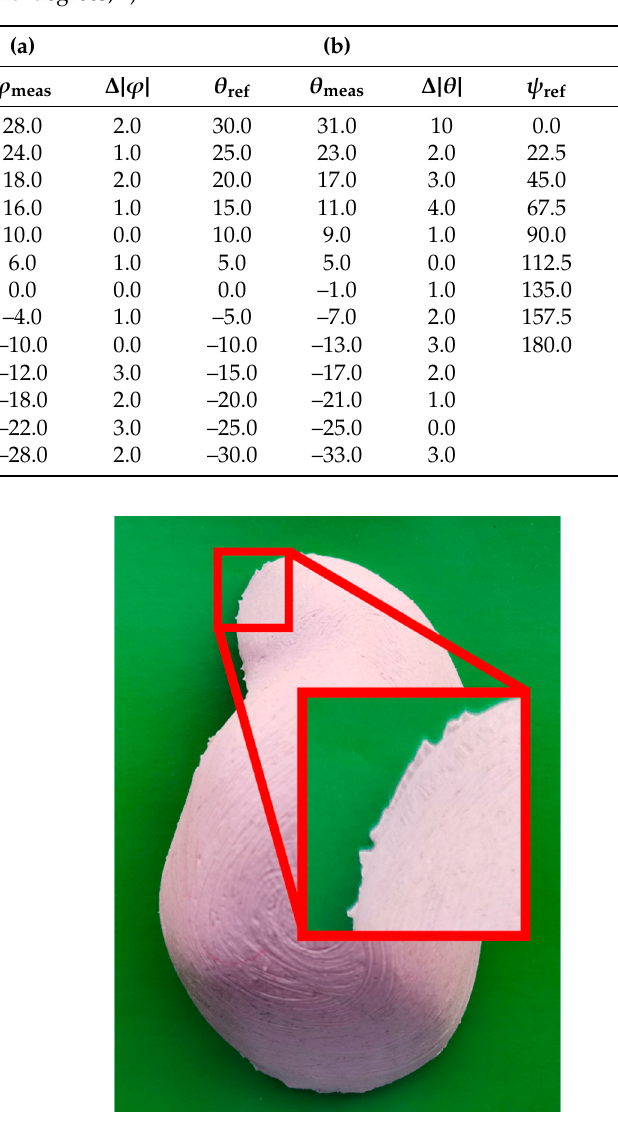
Figure 13. Liver phantom mold edge accuracy. Table 1. Detection accuracy of phantom rotation angles. ( a ) Difference ∆ | φ | between reference rotation φ ref and angle φ meas about the X axis detected by the system for the phantom placed on the table (Unit: degrees, °). ( b ) Difference ∆ | θ | between reference rotation θ ref and angle θ meas about the Y axis detected by the system for the phantom placed on the table (Unit: degrees, °). ( c ) Difference ∆ | ψ | between reference rotation ψ ref and angle ψ meas about the Z -axis detected by the system for the phantom placed on the table. (Unit: degrees, °).